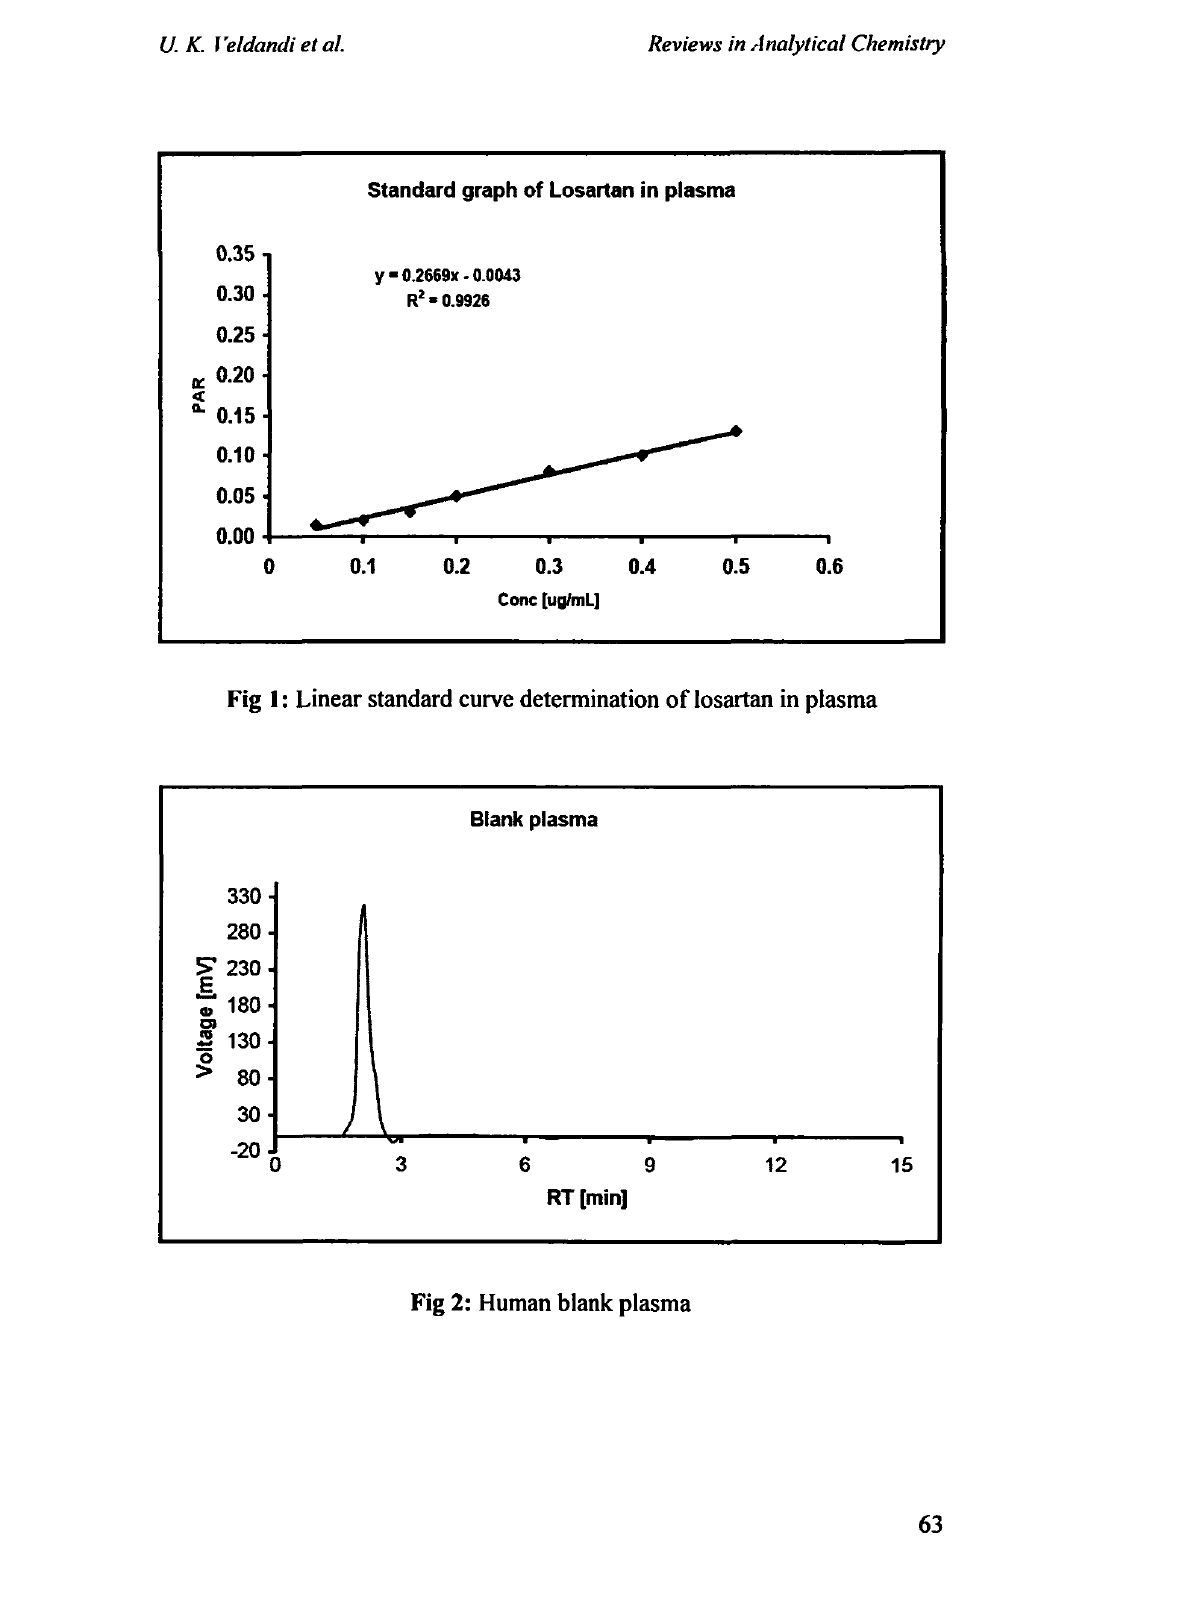
Fig 2: Human blank